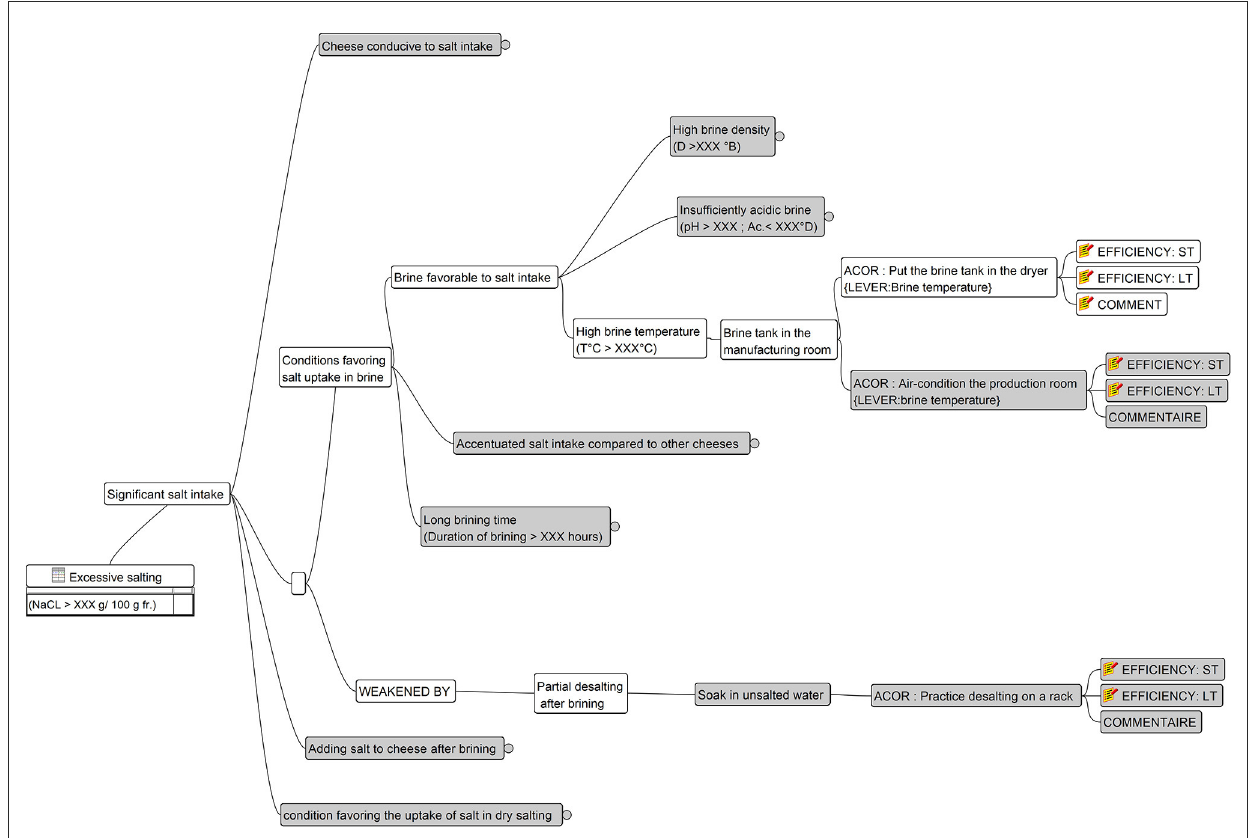
FIGURE3 An excerpt of the mind-mapping file associated with the Excessive salting situation of interest.